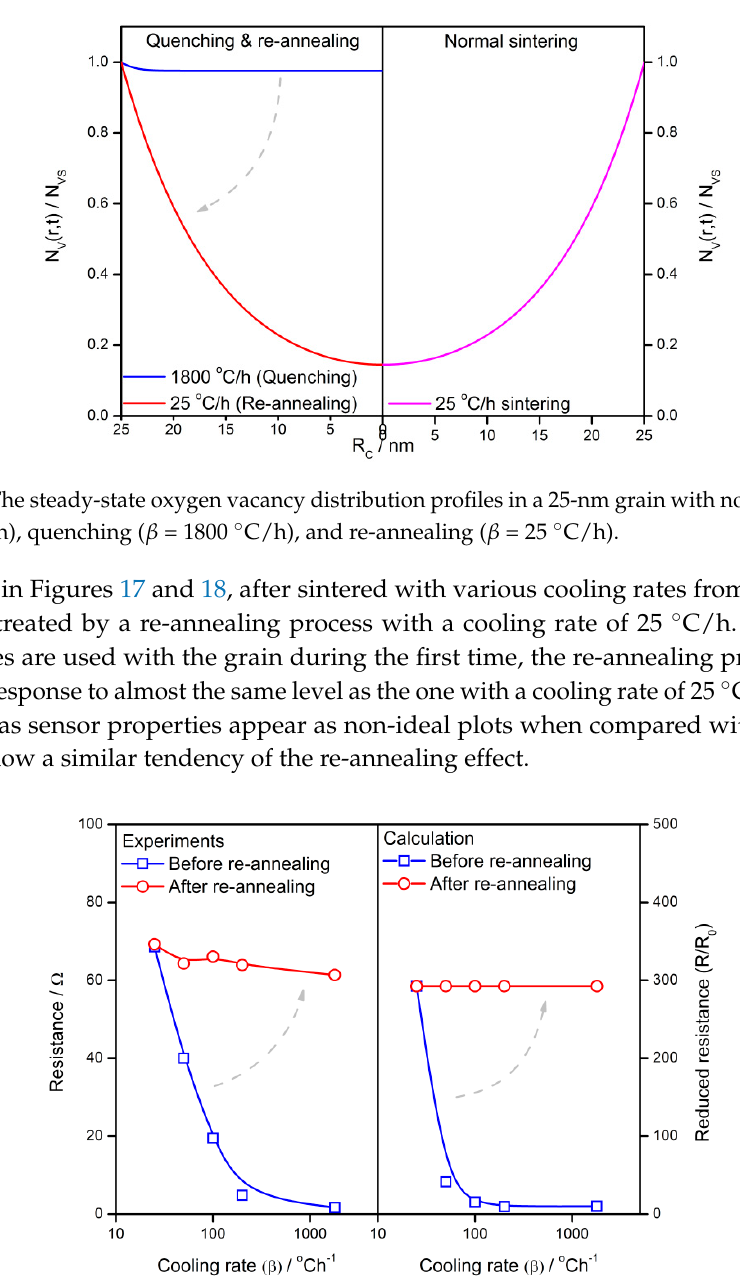
Figure 17. The re-annealing effect of experimental and calculated resistance of semiconductor gas sensors.